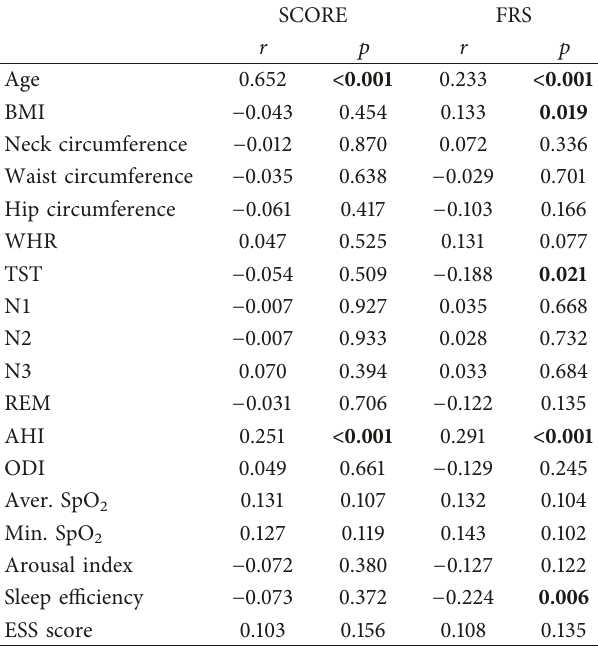
Table 4: Association between Systematic Coronary Risk Evaluation (SCORE), Framingham Risk Score (FRS), and anthropometric and sleep